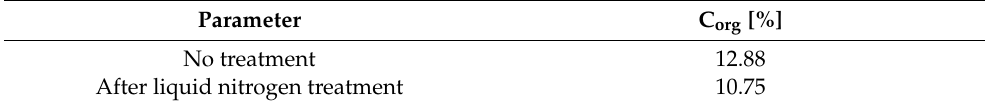
Table 7. Results of C org determination.